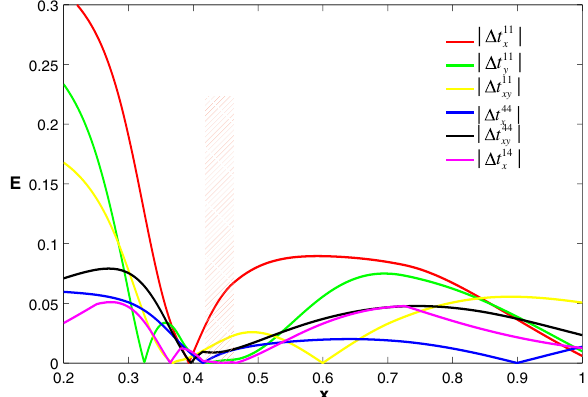
FIG. 10. The changes of hoppings as a function as x . Energy is in Rydberg